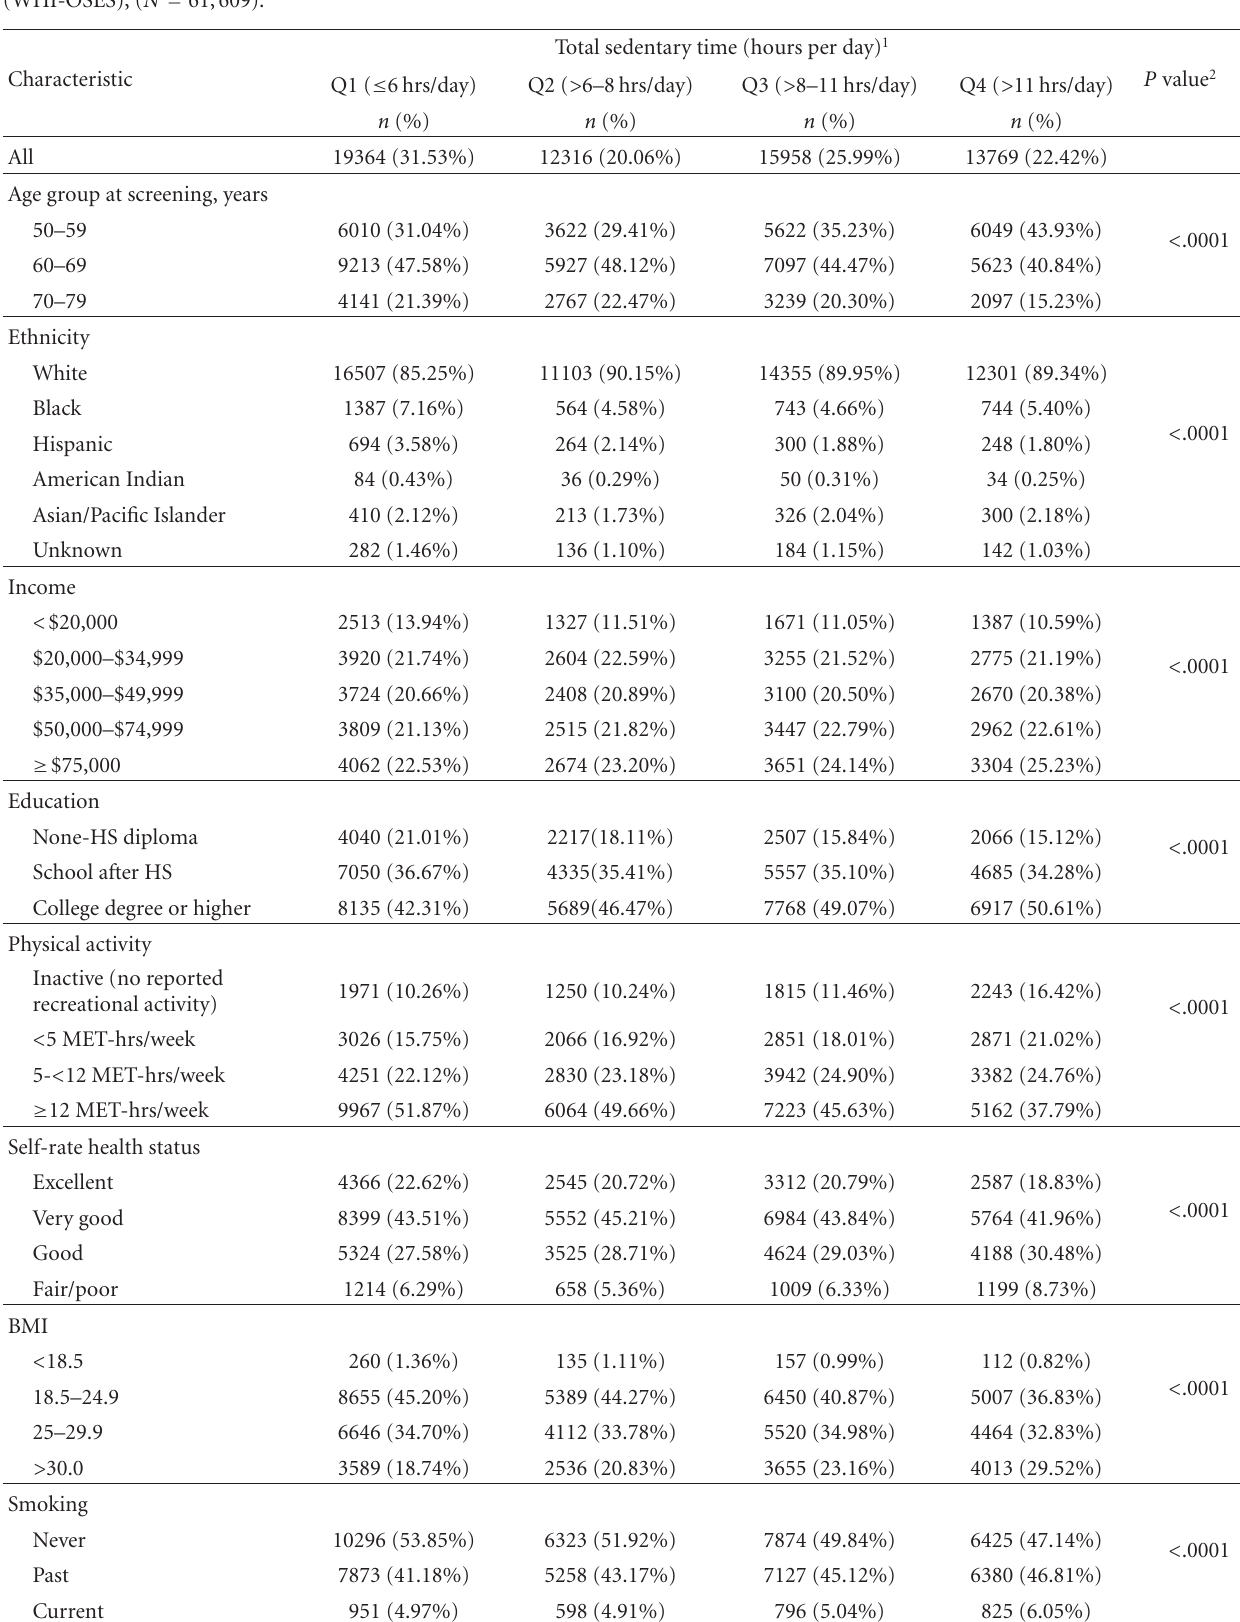
Table 1: Baseline characteristics of participants by total sedentary time, Women’s Health Initiative Observational Study and Extension Study (WHI-OSES), ( N =